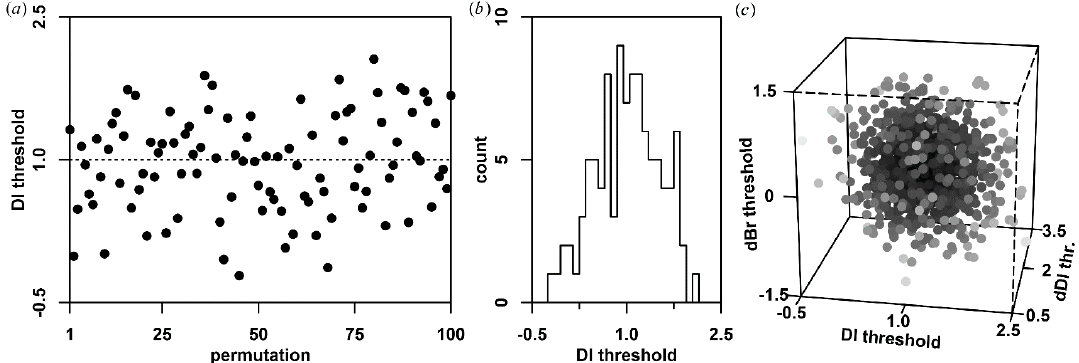
Figure 5. Illustration of the threshold permutation with random numbers for the normal distribution: ( a ) sequentially generated random numbers; ( b ) histogram of the random numbers; and ( c ) three-dimensional example of the combined threshold confidence area for a large number of permutations (1000). Darker colors represent data points that are located in proximity to the confidence centroid.